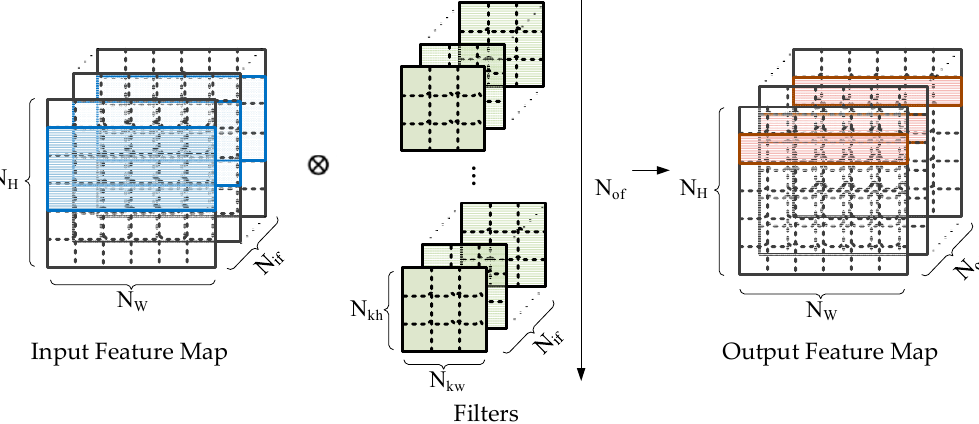
Figure 9. The calculation process of generating a row of the output feature map. N if and N of represent the input channels and output channels, respectively. N W and N H are the width and height of the feature map, respectively. N kw = 3 and N kh = 3 are the width and height of the filters, respectively.